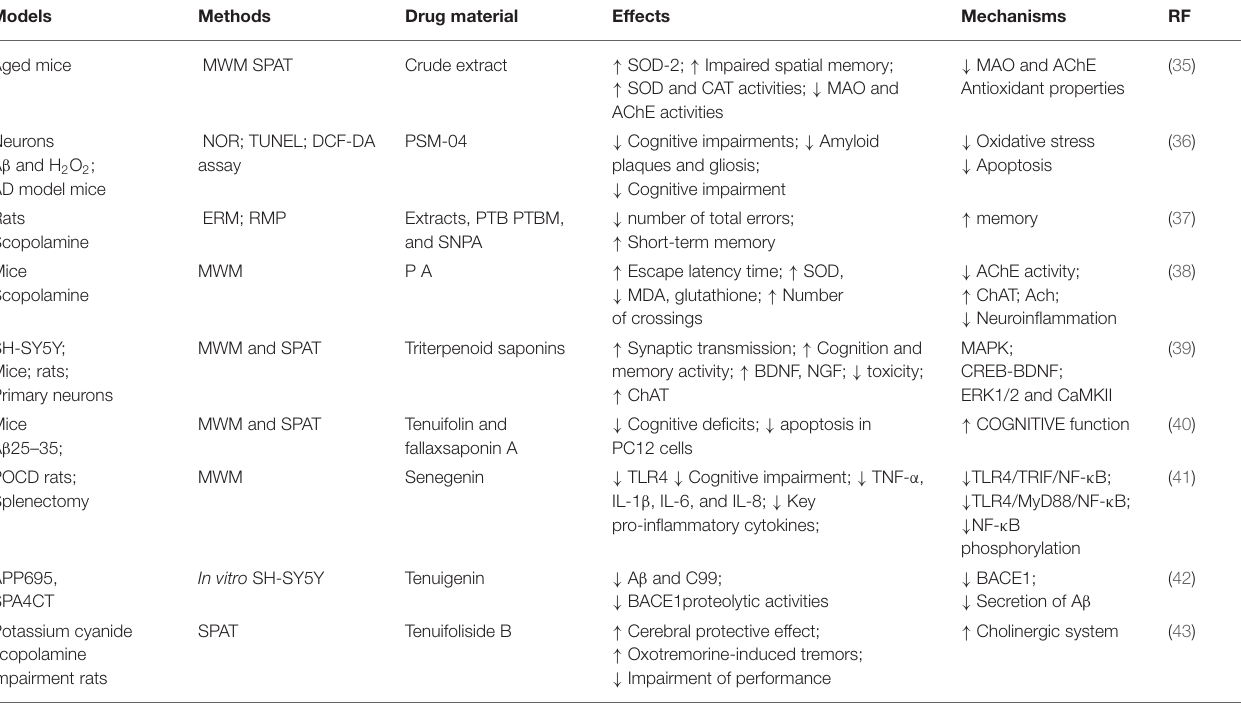
TABLE 2 | Summarized effects of RP on improving learning, memory, and cognitive function in the nervous system. Models